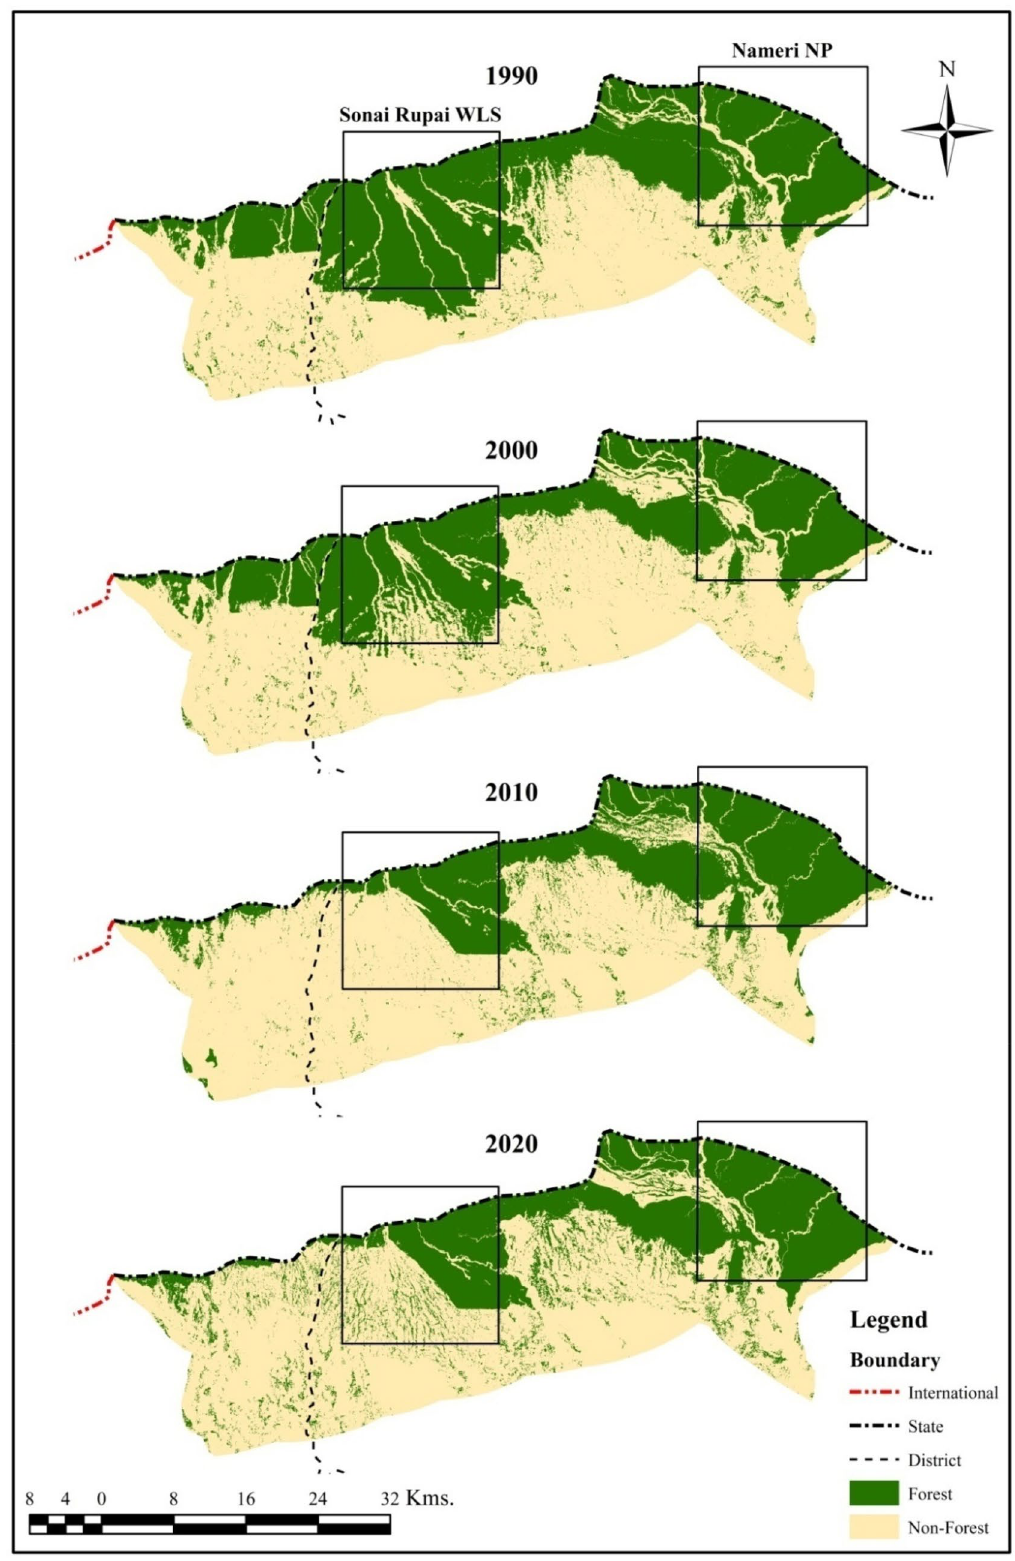
Figure 3. Forest cover map of 1990, 2000, 2010 and 2020 (Generated by the authors using ERDAS Imagine version 2014, http:// hexag ongeo spati al.